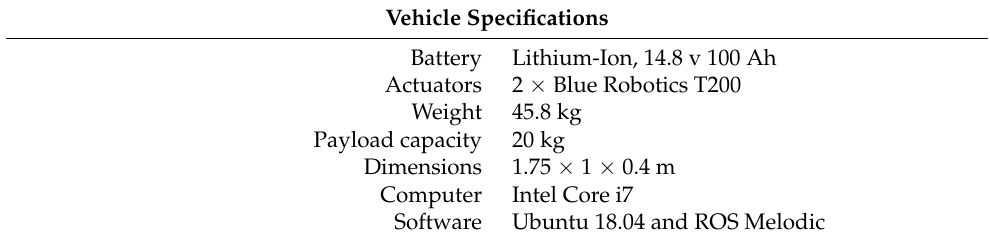
Table 1. Main components and specifications for Xiroi II ASV.